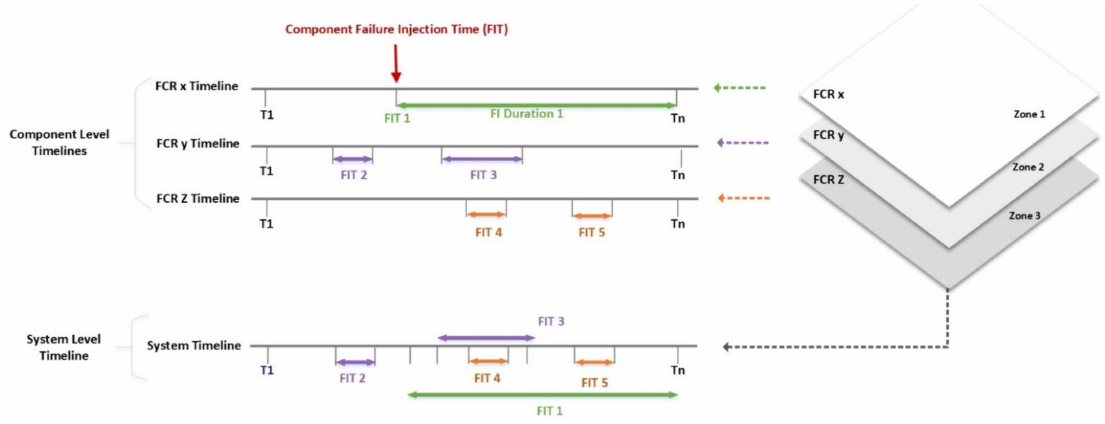
Figure 4. A system-level timeline for multiple-fault injection occurring in multiple FCRs in different zones.